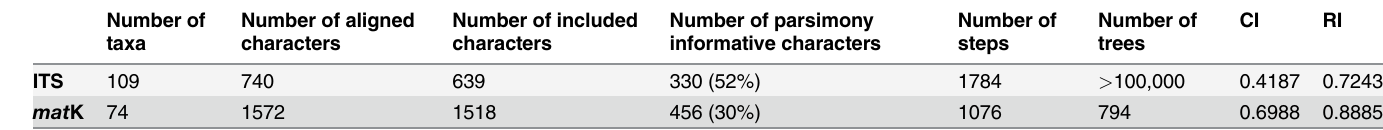
Table 1. Summary of the statistics of the phylogenetic analyses that were conducted on both the ITS and mat K datasets.